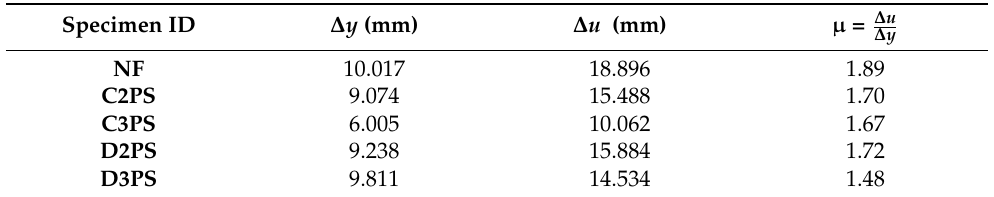
Table 6. Ductility ratio for tested specimens.